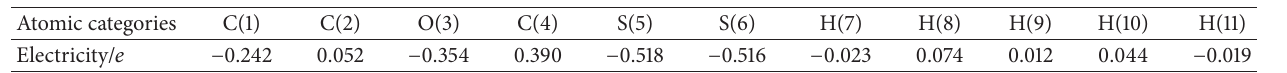
Table 5: Mulliken charge distribution of optimization of ethyl xanthate